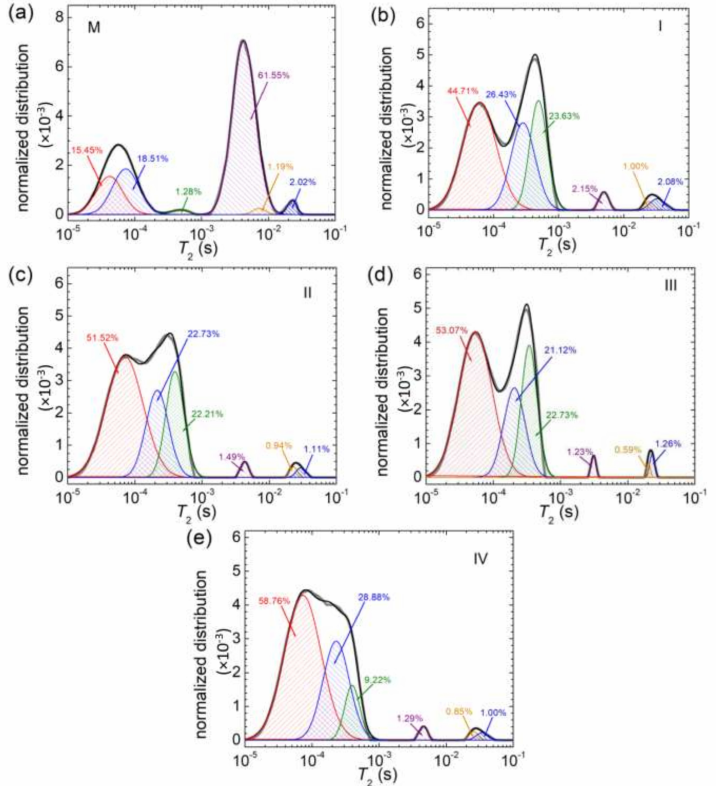
Figure 11. The deconvolution with six dynamics components of T 2 -distributions measured for ( a ) M; ( b ) I; ( c ) II; ( d ) III and ( e )